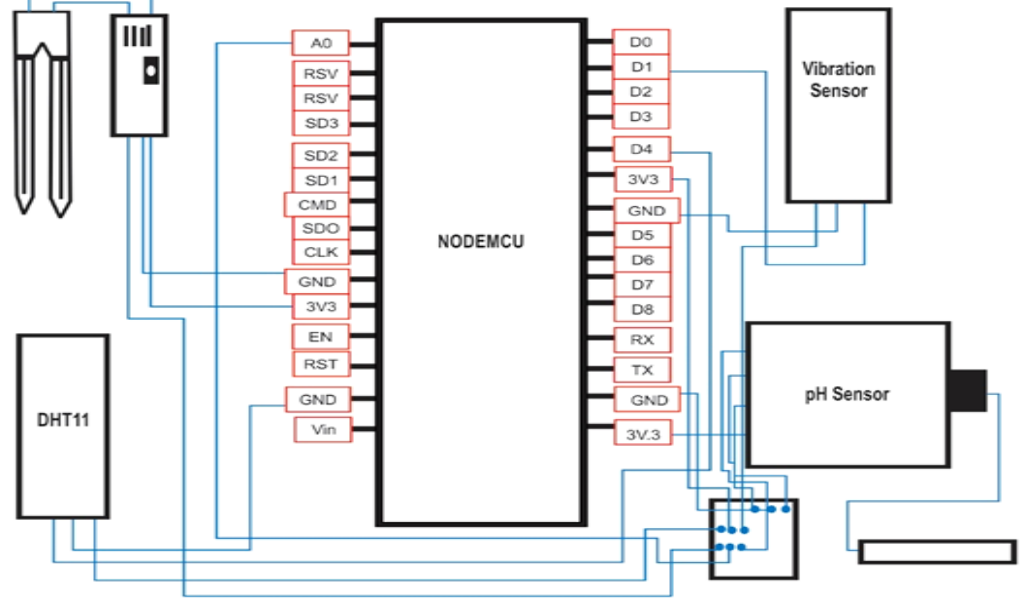
Figure 14. Complete wiring diagram for plant health monitoring